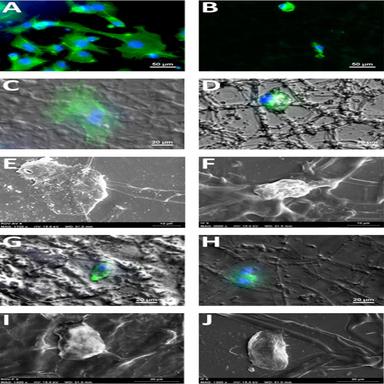
Comparison of endothelial HUVEC and fibroblast HFF1 adhesion and morphology on bioactive REDV-ELR and negative control IK-ELR after 16 h of seeding. Panel A: samples are represented as the average cell number normalized with respect to field area. Panel B: representation of average cell areas. Error bars represent the standard error of the mean. Statistical differences were considered significant at p < 0.05.